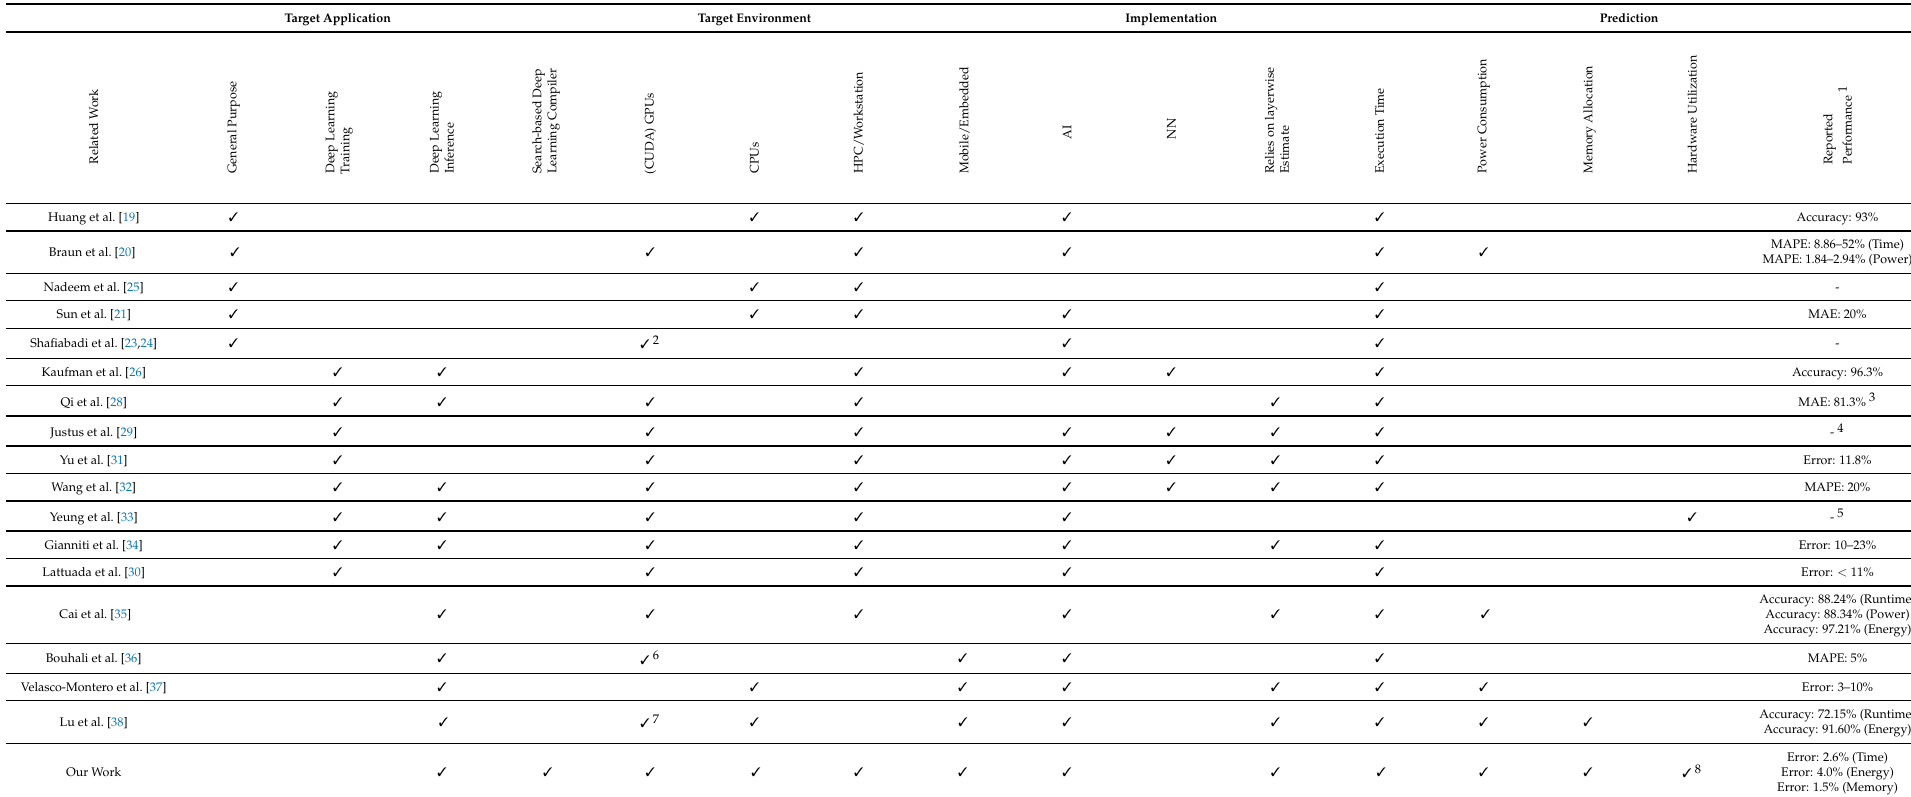
Table 1. Comparison of related work with our own contribution. The performance data reflects what these publications